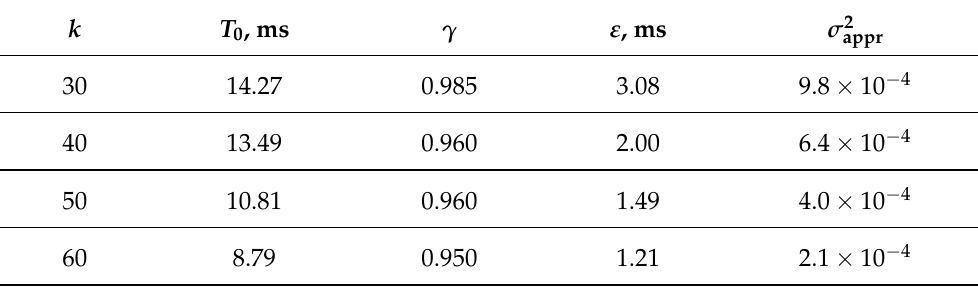
Table 1. Values of the parameters T 0 , ε and γ in the Formula (4) fitted for different k with the mean-squared-normalized error of approximation σ 2 appr